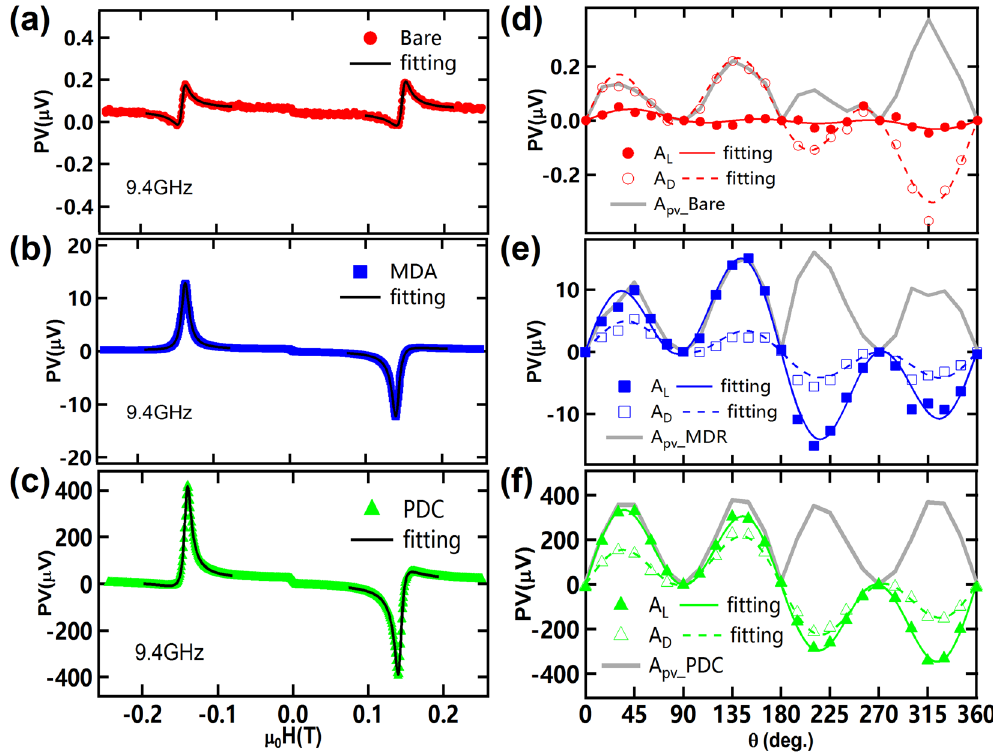
Figure 3. Line shapes of PV and Lorentzian and dispersive amplitudes for three structures. Panels (a)–(c) show the measured microwave PV line shapes for the PDC, MDA, and bare structures (at 9.4 GHz), respectively. Panels (d)–(f) show A L , A D and A PV with respect to θ